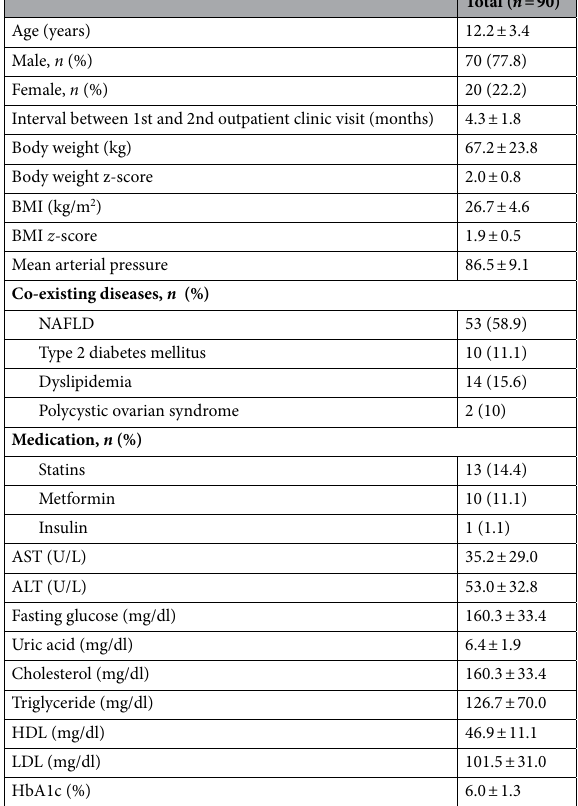
Table 1. Baseline characteristics of pediatric patients with obesity. BMI body mass index, NAFLD non- alcoholic fatty liver disease, AST aspartate transferase, ALT alanine transferase, HDL high-density lipoprotein, LDL low-density lipoprotein, HbA1c hemoglobin